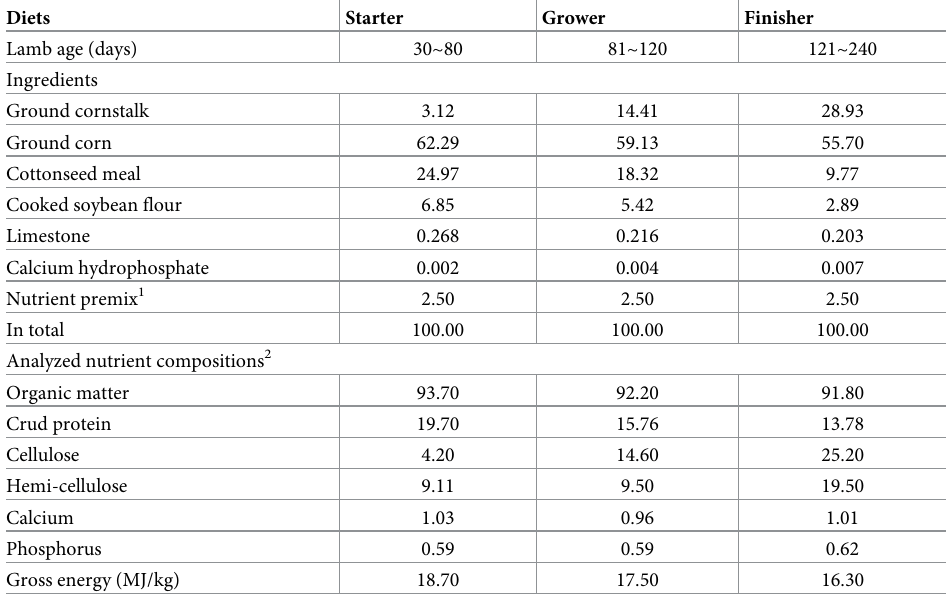
Table 1. The ingredients and nutritional compositions of the basal diets for lambs (%, dry matter basis). Diets Starter Grower Lamb age